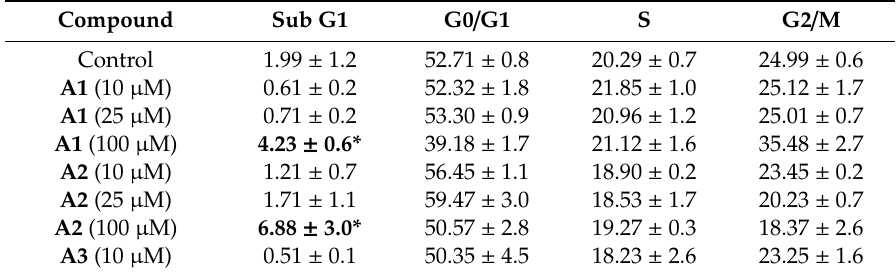
Figure 2. MDR reversal assessed by flow cytometric detection of Rhodamine123 e ffl ux in MES-SA-DX5 cells. Cells were suspended in RPMI 1640 and treated with verapamil (Ver, positive control) or synthesized derivatives. After incubation for 20 min, 5 µ M Rh123 was added, the cells were incubated for another 20 min at 37 ◦ C and then centrifuged and washed twice with ice-cold PBS and resuspended in PBS. The fluorescence caused by the presence of Rh123 in cells was measured using a flow cytometer with excitation and emission wavelengths of 488 nm and 530 nm, respectively. The values represent the mean ± S.E.M. of 3–5 experiments. * The di ff erence between treated and controlled cells are statistically significant ( p < 0.05). Table 2. Flow cytometric analysis of cell cycle distribution of MES-SA-DX5 cells treated with synthesized